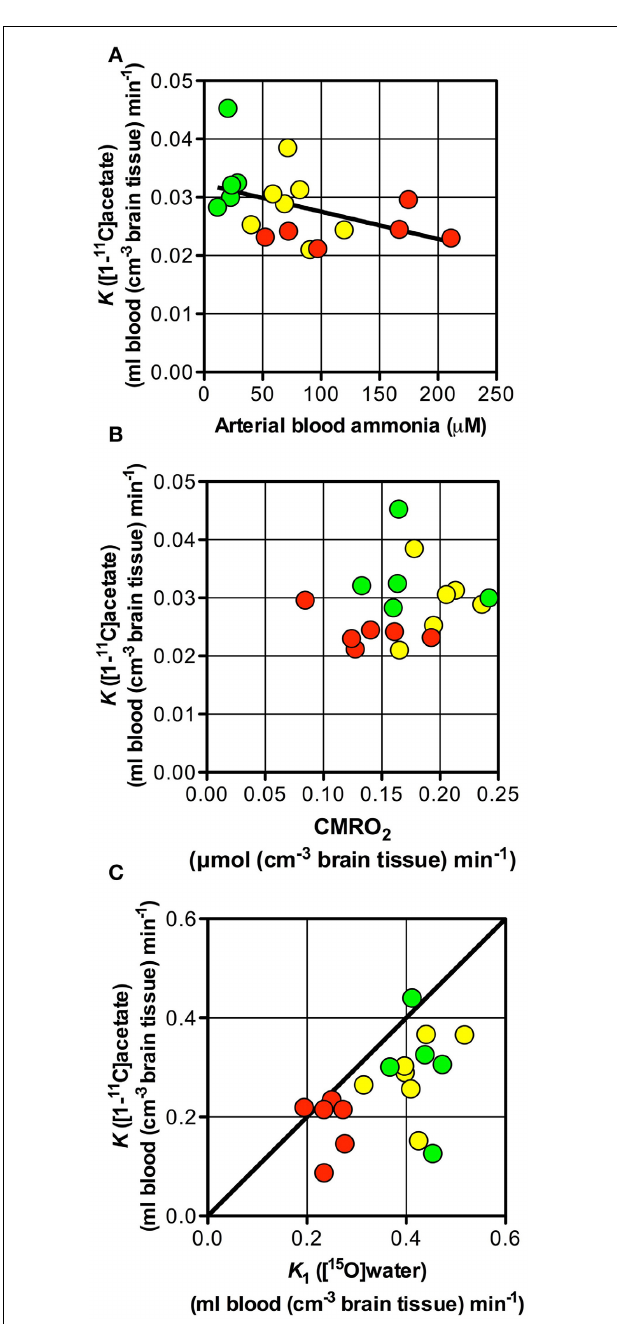
FIGURE 5 | Net metabolic clearance and unidirectional clearance from blood-to-brain tissue of [ 11 C]acetate vs. arterial blood ammonia, unidirectional clearance of H 2 [ 15 O] and cerebral metabolic rate of oxygen. Patients with cirrhosis and hepatic encephalopathy (HE) ( ), patients with cirrhosis without HE ( ), and healthy subjects ( ). (A) Net metabolic clearance of [ 11 C]acetate, K vs. arterial blood ammonia concentration (the latter from Iversen et al., 2009). (B) Net metabolic clearance of [ 11 C]acetate, K vs. cerebral metabolic rate of oxygen, CMRO 2 (the latter from Iversen et al., 2009). (C) Unidirectional clearance from blood-to-brain tissue of [ 11 C]acetate, K 1 vs. that K 1 of H 2 [ 15 O] (the latter from Iversen et al., 2009); the straight line shows line of identity. Solid line indicates a